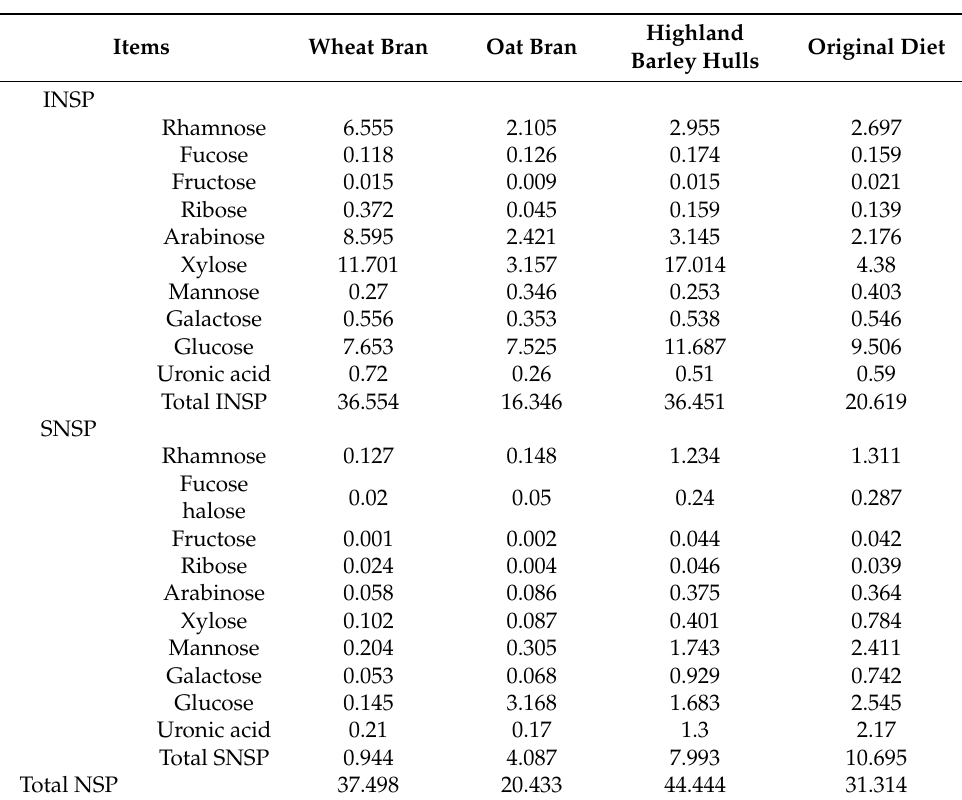
Table 7. Determination of fiber components in feed materials,